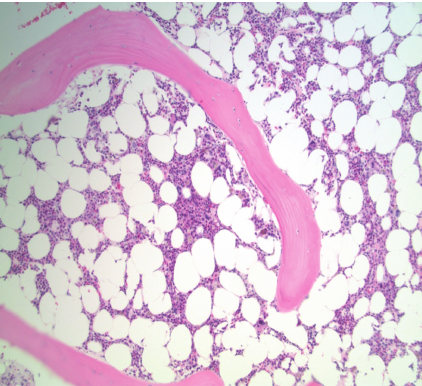
Figure 1: Bone marrow showing hypocellularity and trilineage hematopoiesis, without increased blasts. No increased fibrosis or dysplastic changes are